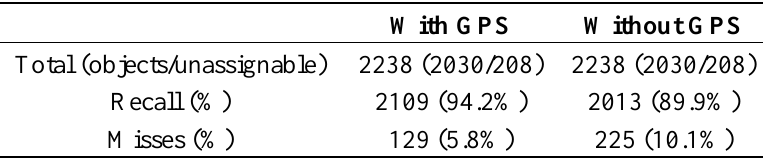
Table 1. Performance of our tracking